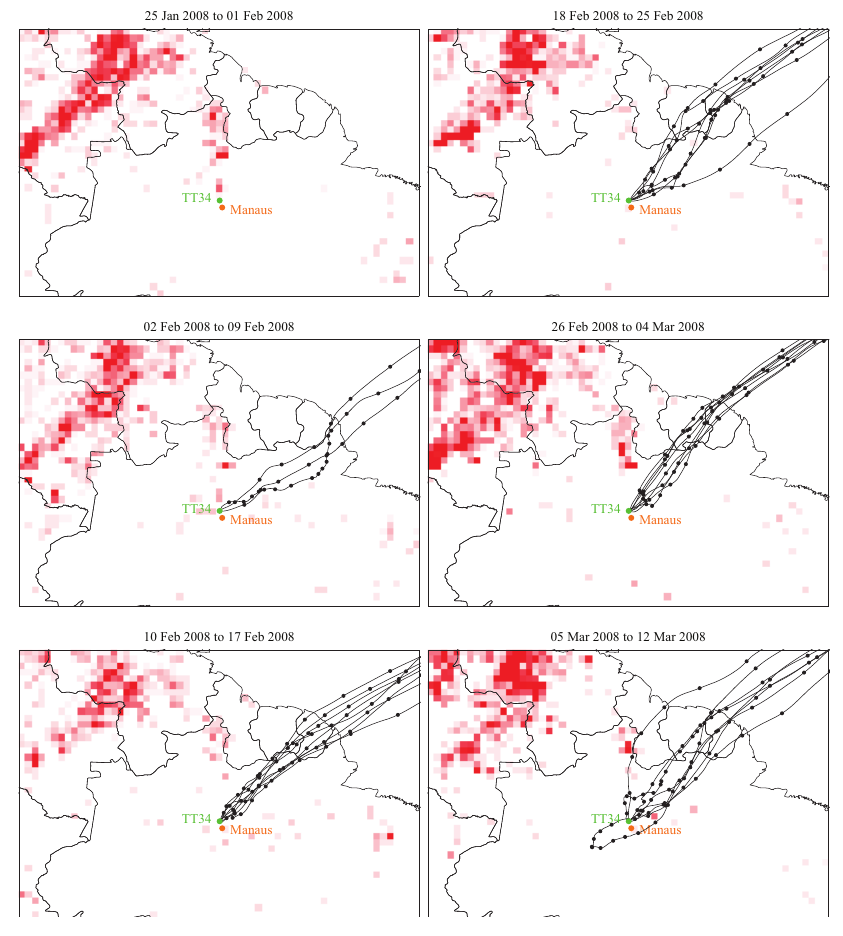
Fig. 8. Gridded statistical summaries of fires in the central and northern Amazon Basin. Red is scaled from 0 to 25 pixel fire counts; the maximum value for the shown scenes is 200. Further information is provided in the caption to Fig. 6. The HYPSLIT backtrajectories at 200m that terminate at TT34 during the eight-day period are shown beginning 7 February 2008 (i.e., corresponding to the start of AMAZE-08 measurements). Markers represent steps of 12h. The trajectory that loops back around from Manaus is for 7 March